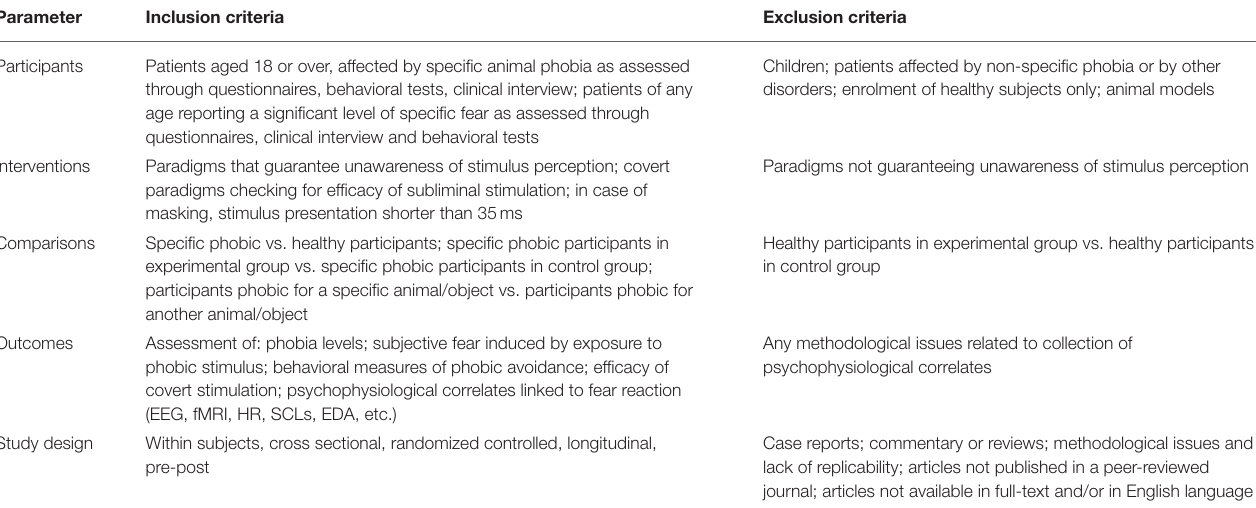
TABLE 1 | PICOS. Parameter Inclusion criteria Exclusion criteria